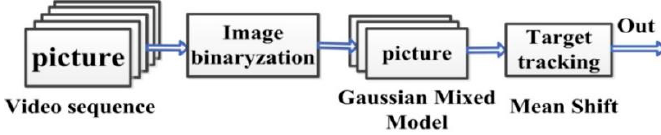
Figure 5. The scheme of target detection and tracking.